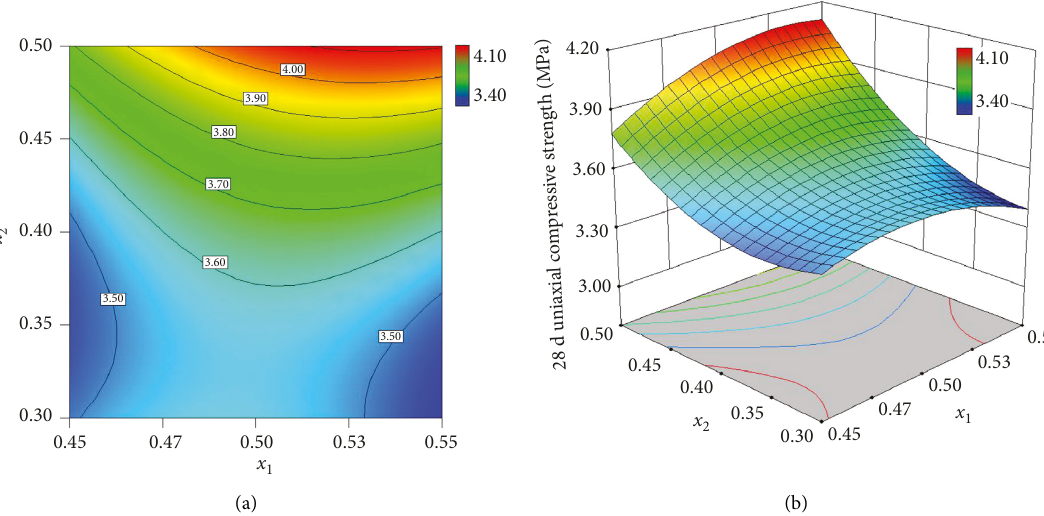
Figure 12: Interaction influence of x 1 and x 2 on 28d compressive strength. (a) Two-dimensional diagram. (b) Three-dimensional diagram.